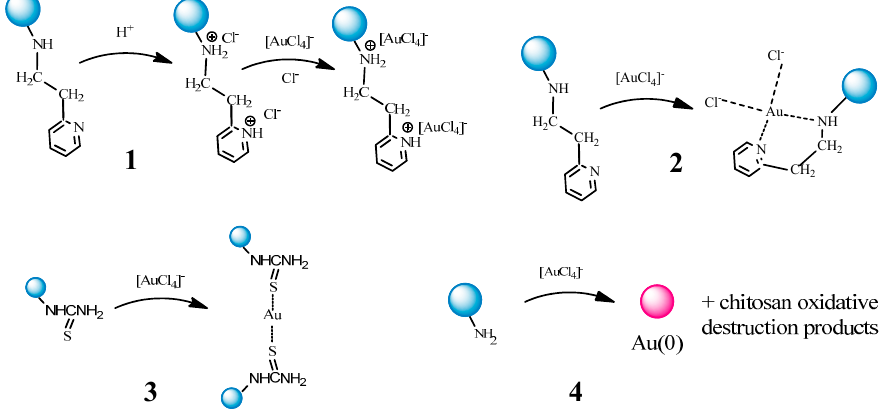
Figure 13. Possible mechanisms of metal anion complexes interactions with chitosan and its derivatives: